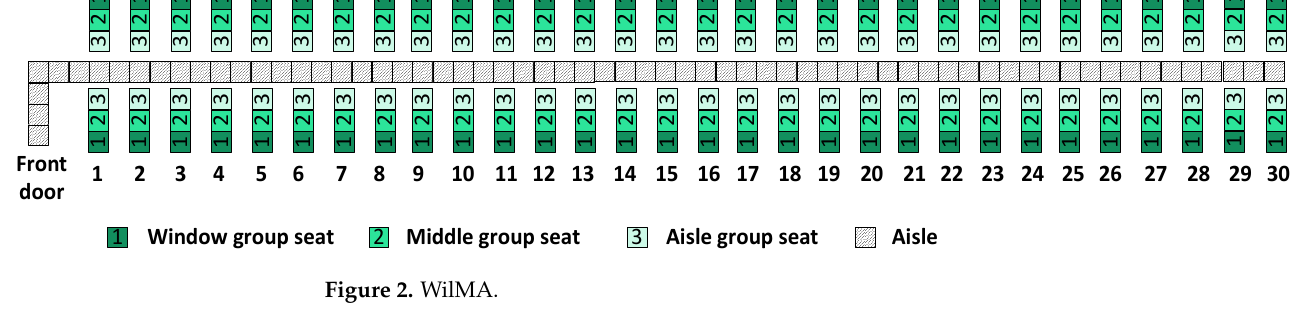
3 Figure 3. Back-to-front-by-3-groups. Figure 4. Back-to-front-by-4-groups.